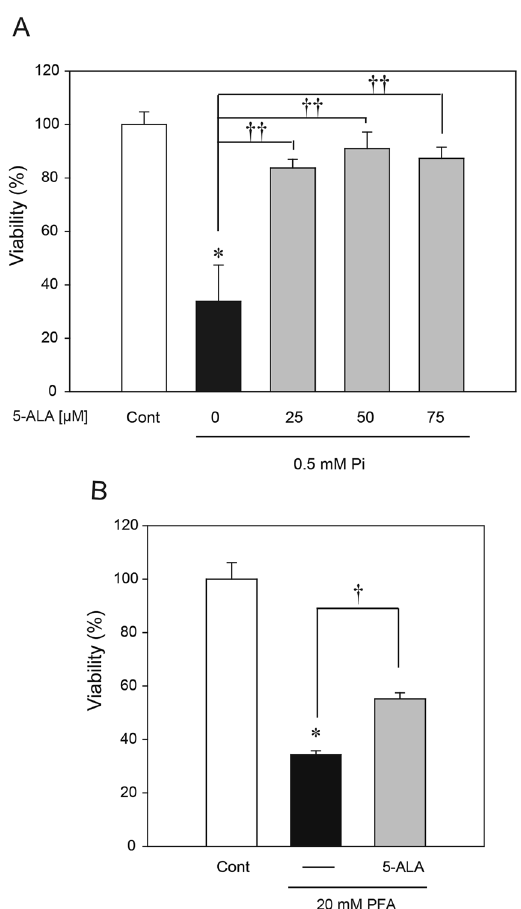
Figure 3. Effects of 5-ALA on low Pi-induced cell death. ( A ) MTT assay for cell survival at 48 h after simultaneous treatment with 0.5 mM Pi in the absence or presence of 5-ALA (at 25, 50, 75 µ M). ( B ) MTT assay for cell survival at 24 h after simultaneous treatment with 20 mM PFA in the absence or presence of 50 µ M 5-ALA. Each value represents the mean ± SEM of three determinations, based on the viability of the untreated culture being 100% (control). The significance of any difference was determined using ANOVA, followed by the Bonferroni/Dunn post-hoc test ( * p < 0.05 versus control; † p < 0.05, †† p < 0.01 versus treatment with 0.5 mM Pi or 20 mM PFA